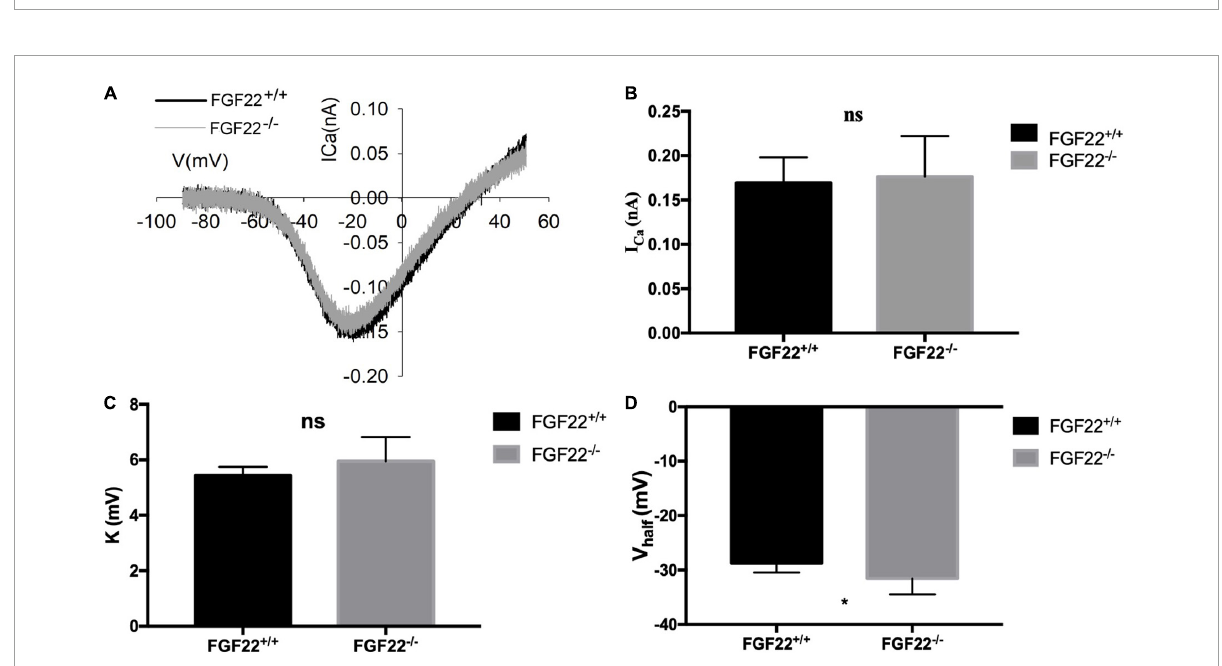
FIGURE5 Changes in Ca 2 + current in IHCs of the Fgf22 + / + and Fgf22 − / − groups. (A) Representative curves of the Ca 2 + current in IHCs of the Fgf22 + / + (black) and Fgf22 − / − (gray) groups. The current response was induced by a voltage ramp from –80 to 60 mV and then the leak was subtracted. (B,C) No significance was found in the Ca 2 + current amplitude ( I Ca ) and the slope factor ( k ) between the Fgf22 + / + and Fgf22 − / − groups. (D) IHCs from the Fgf22 − / − mice (–31.55 mV) have a more negative half-activation voltage ( V half ) than Fgf22 + / + mice (–28.76 mV). * P = 0.0301, which indicates significant differences with P < 0.05. Statistical significance was assessed with a two-way ANOVA followed by Bonferroni post hoc